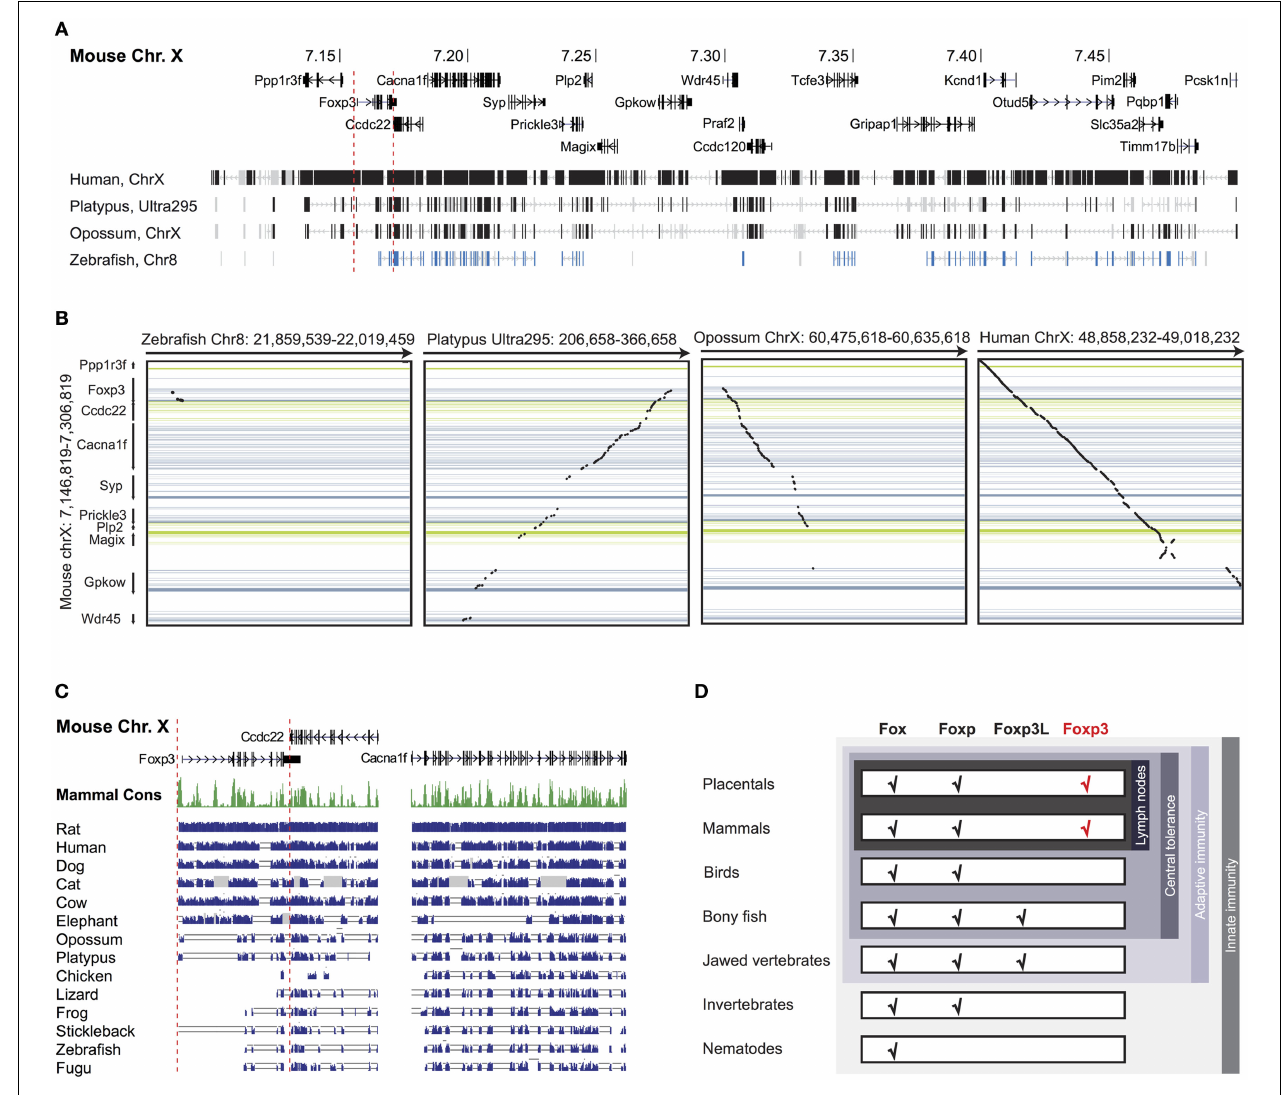
UCSC Genome browser with the height of the green bars denoting the level of conservation in all species determined by BLASTZ (Miller et al., 2007). A discontinuous whole genome nucleotide alignment of the mouse genes in this region with those of other species, irrespective of their location in the genome, are shown as blue bars.The height of the bars corresponds to the level of conservation. Low quality or missing sequence data is shown as gray boxes and alignment gaps are shown as gray double lines. For clarity, only regions containing genes are shown. (D) Conservation of Fox family members.The emergence of the Foxp subfamily coincides with the evolution of adaptive immunity in jawed vertebrates.